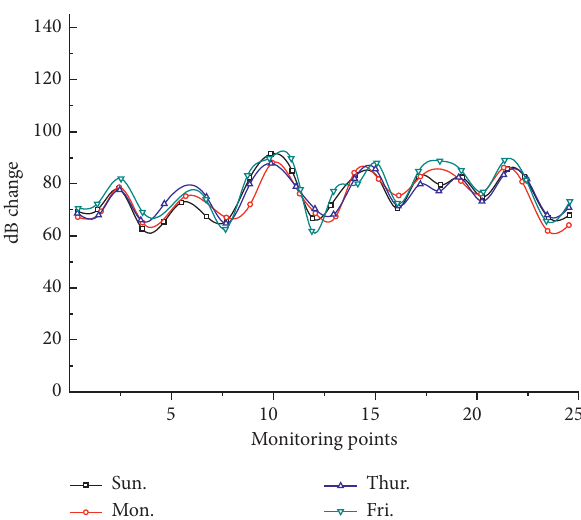
Figure 4: Noise levels at 12 p.m. for the 24 measuring points.